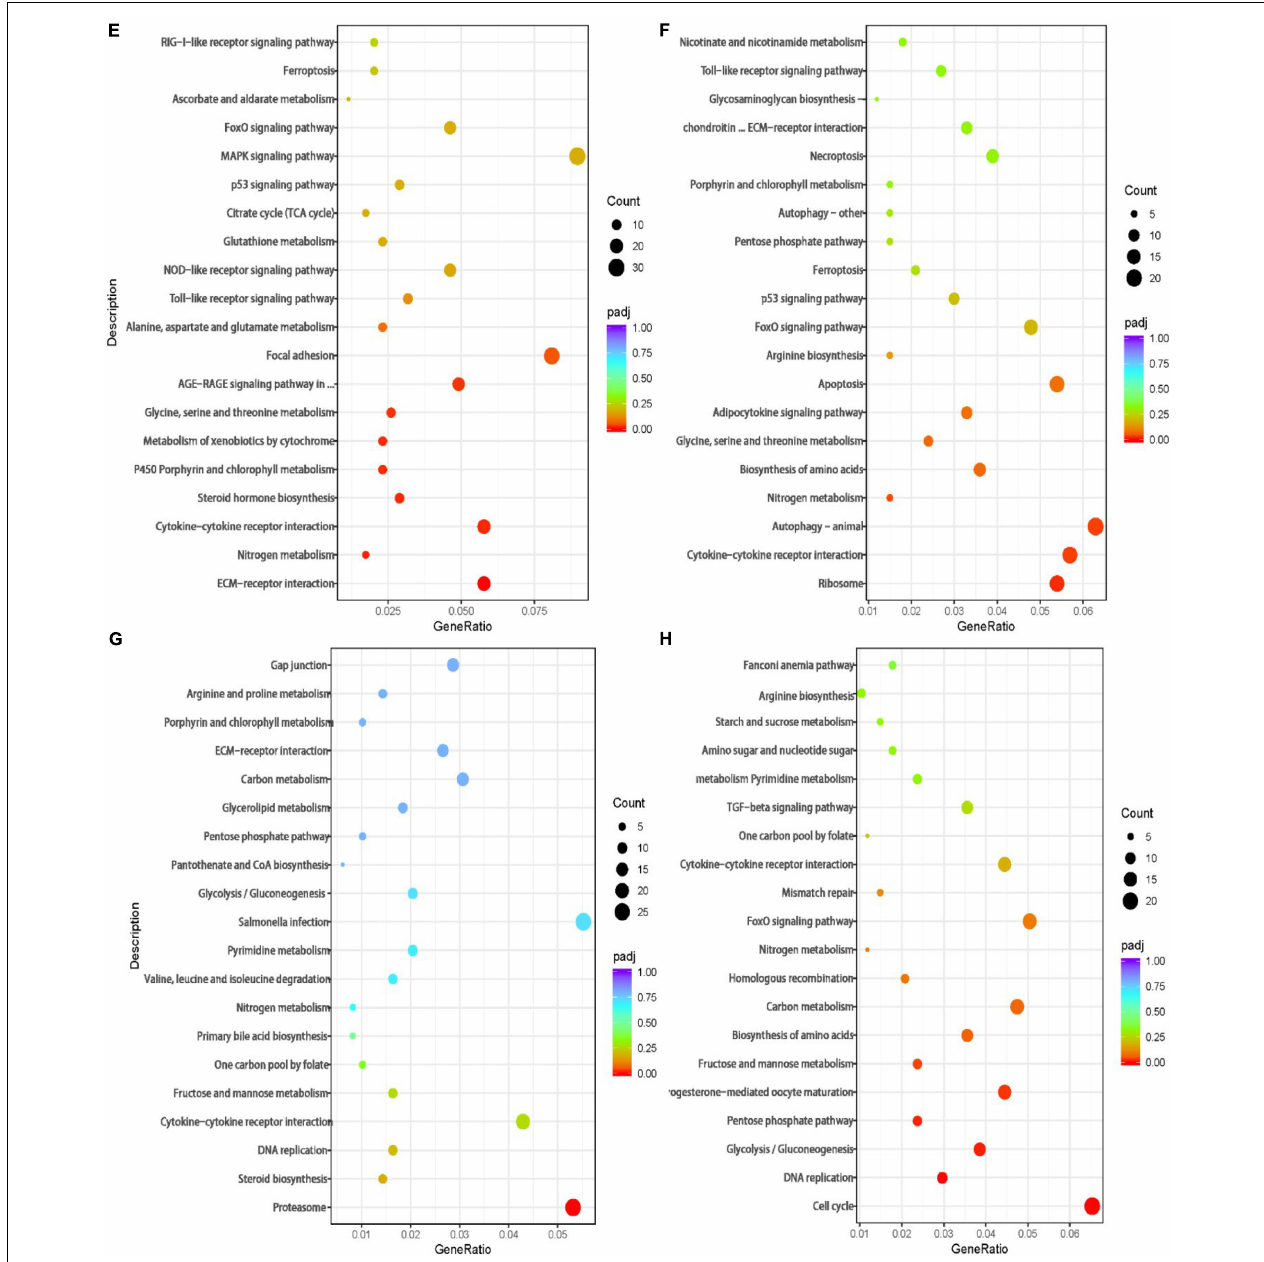
FIGURE 3 | Bubble chart of KEGG pathway enrichment of the DEGs in the (A) 4 vs. 0 h, (B) 8 vs. 0 h, (C) 12 vs. 0 h, (D) 24 vs. 0 h, (E) R12 vs. 0 h, (F) R24 vs. 0 h, (G) R12 vs. H24 h, and (H) R24 vs. H24 h. The vertical axis represents the pathway categories, and the horizontal axis shows the gene ratio. The point size shows the number of DEGs enriched to the KEGG pathway. The point color shows different Q values as indicated on the